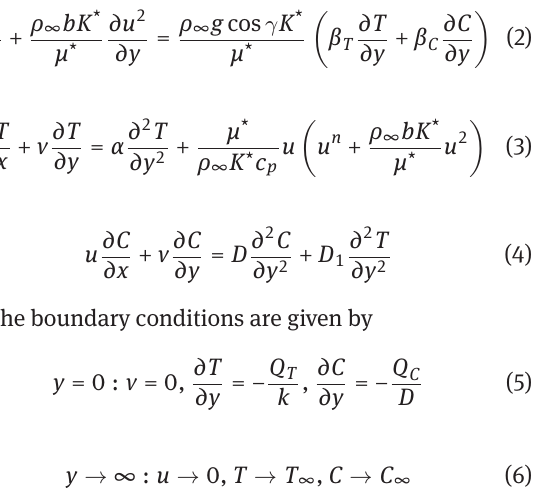
Fig. 1: Physical Model and coordinate